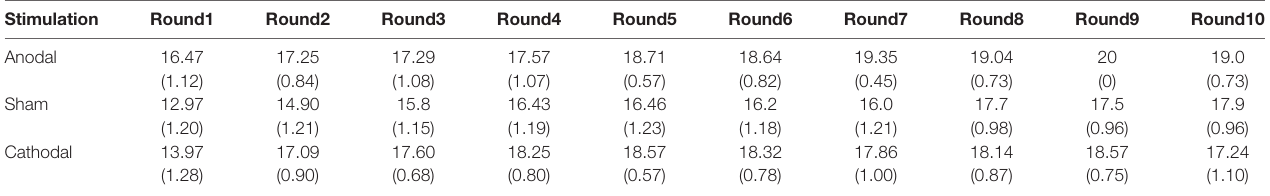
TABLE 3 | Means and SE of the data for loss contributions in public bad games under three conditions. Stimulation